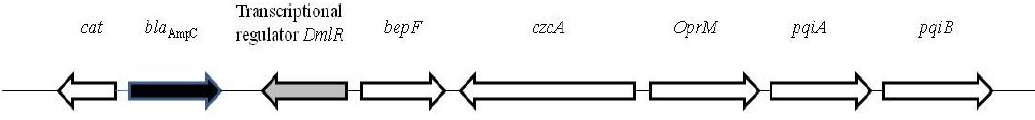
Figure 1. Genetic surrounding of the bla AmpC gene found in the S. algae strains. The black arrow represents the bla AmpC gene, the grey one the transcriptional regulator, whereas the white ones the other genes found in this